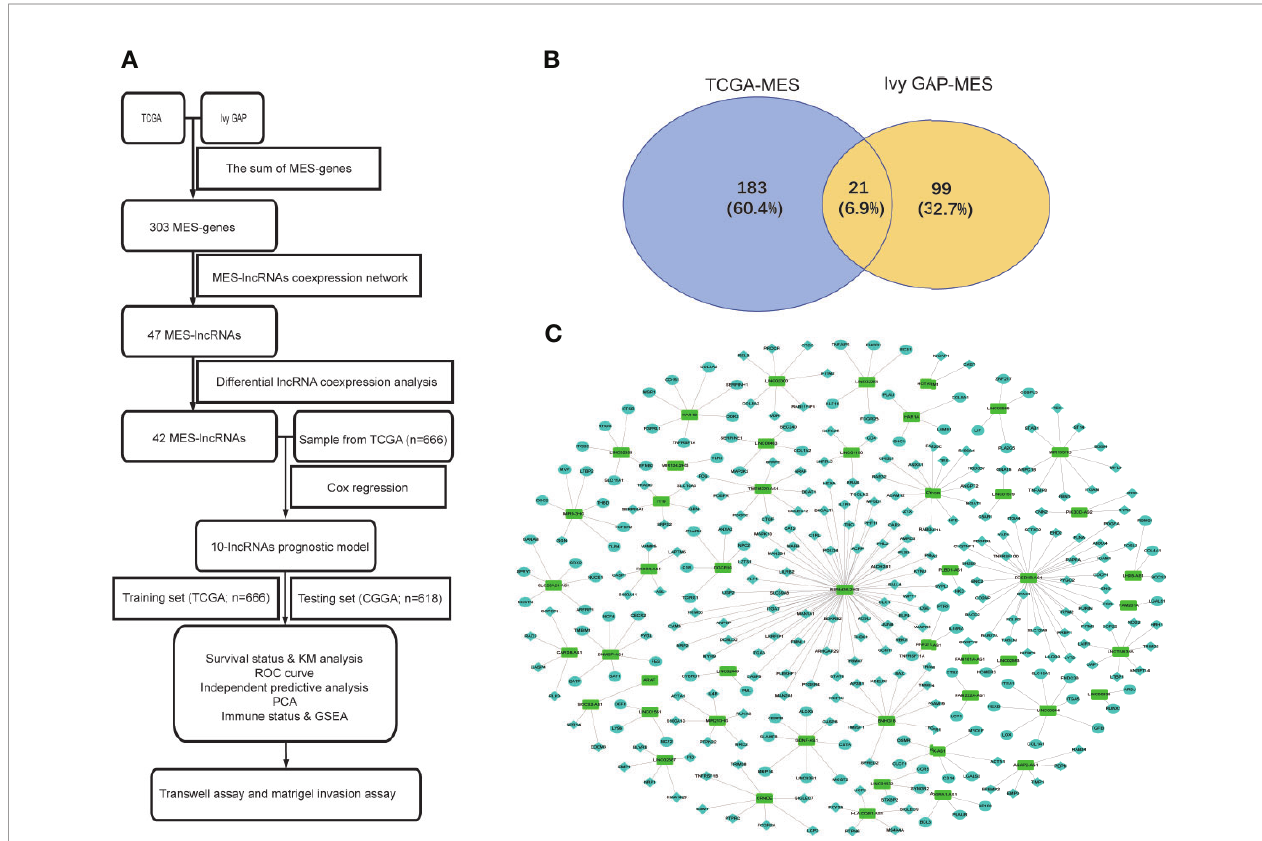
FIGURE 1 | Identi fi cation of MES-related lncRNAs. (A) Flowchart of our study. (B) Venn diagram: the sum aggregate of MES-related mRNAs in the TCGA and Ivy GAP data sets. (C) Network of MES-related lncRNAs with co-expressed MES-related genes in glioma. In the centric position, green nodes indicate MES-related lncRNAs and the sky blue indicates MES-related genes, diamonds indicate positive correlation, ellipses indicate negative correlation. The coexpression network is visualized by CYTOSCAPE 3.4